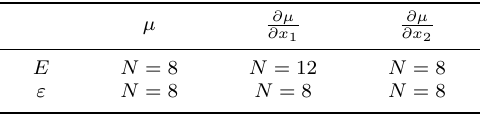
Table 5. The optimized value of N for obtaining the numerical solutions µ,∂µ/∂x 1 ,∂µ/∂x 2 of best error E and efficiency number ε for Case 2.